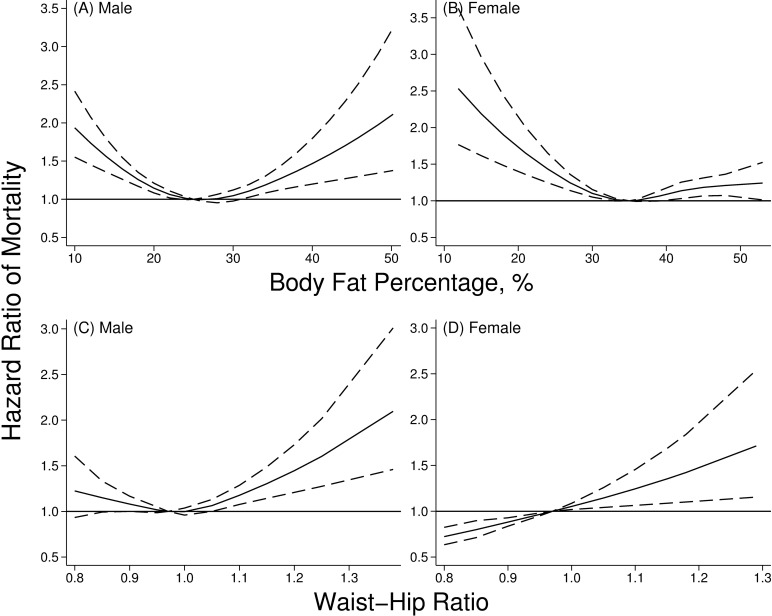
Association between body fat percentage (A and B) and waist-hip ratio (C and D) with hazard ratio of all-cause mortality in males and females, NHAHES 1988–2011. Notes: Solid lines and dash lines represent the hazard ratios and their 95% confidence intervals after adjusting for baseline age and ethnicity.